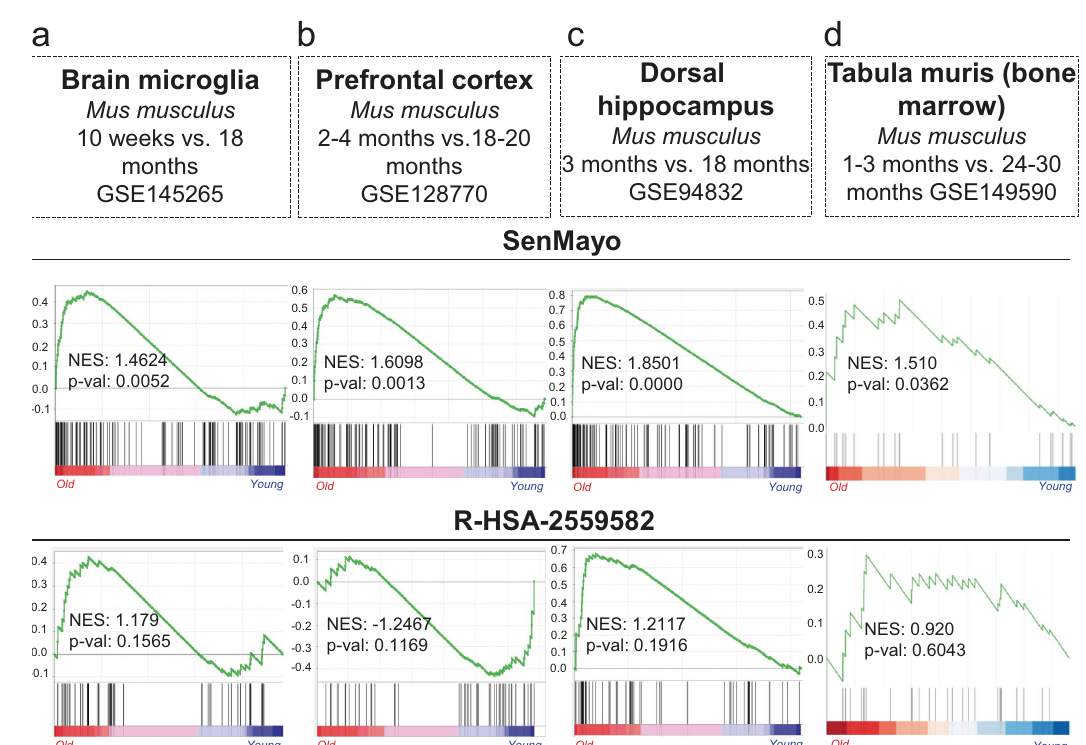
Fig. 2 | The SenMayo gene set predicts aging across tissues and species. a Comparedtotheconventionalgeneset,theSenMayolistissigni fi cantlyenriched during the aging process in murine brain microglia ( p =0.1565 vs. p =0.0052; GSE145265), n =4(2young,2aged,all ♂ ), b murineprefrontalcortex( p =0.1169vs. p =0.0013; GSE128770), n =48 (24 young, 24 aged, all ♂ ), and ( c ) murine dorsal hippocampus ( p =0.1916 vs. p <0.001; GSE94832), n =12 (6 young (3 ♀ ), 6 aged